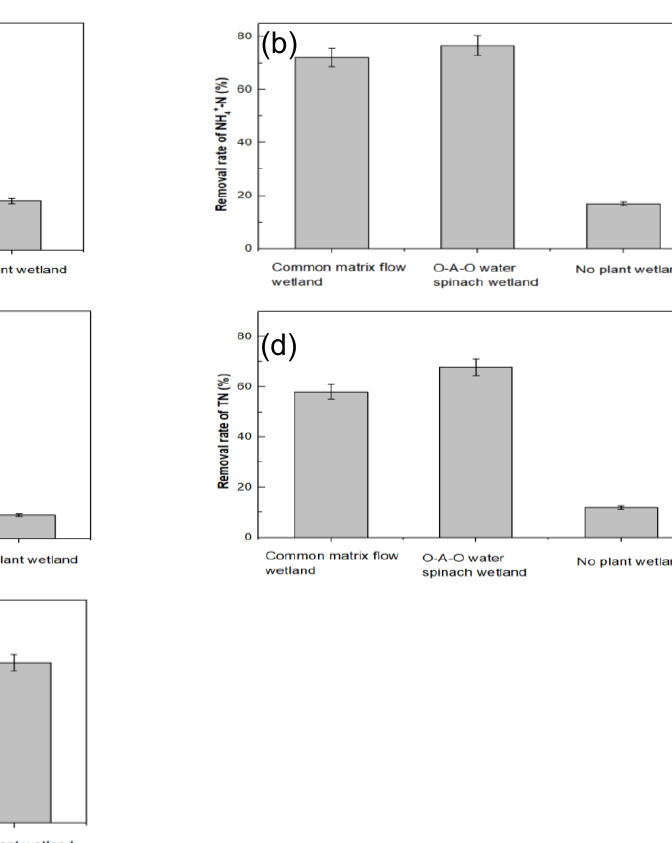
Figure 2. Removal rates of pollutants in three groups of CWs (Constructed Wetlands), ( a ) Removal rate of COD (Chemical Oxygen Demand), ( b ) Removal rate of NH 4+ -N, ( c ) Removal rate of NO 3 − -N, ( d ) Removal rate of TN (Total Nitrogen), ( e ) Removal rate of TP (Total Phosphorus).